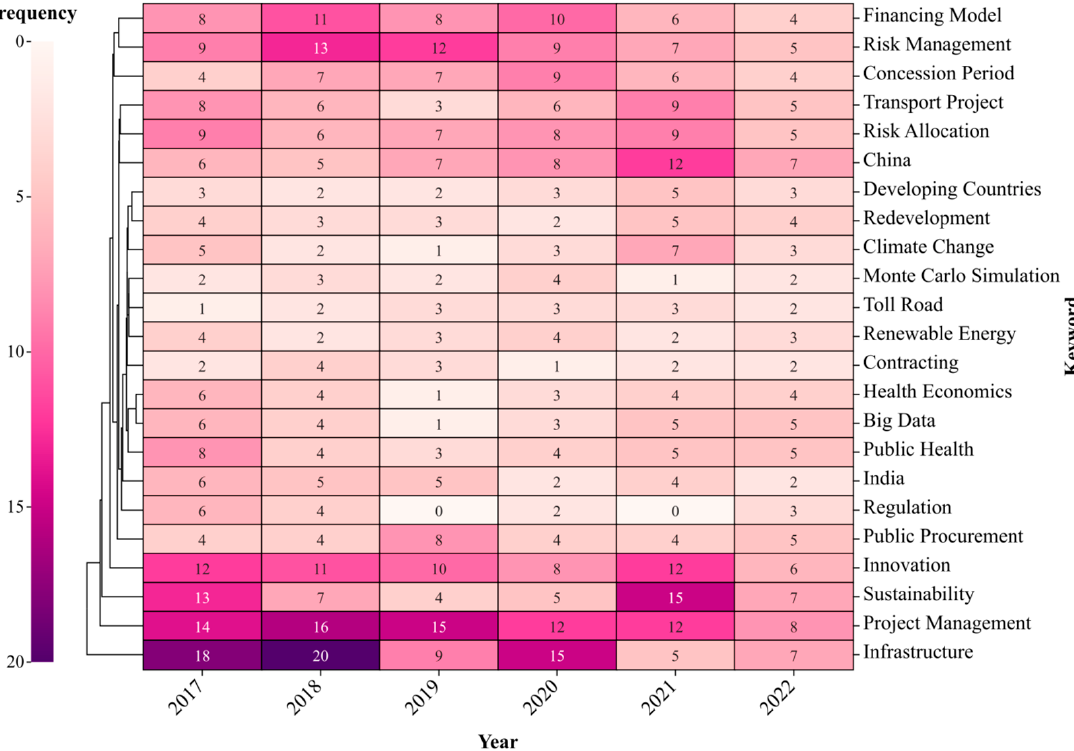
Figure 7. Time Zone Biclustering Analysis in the Steady Development Period.